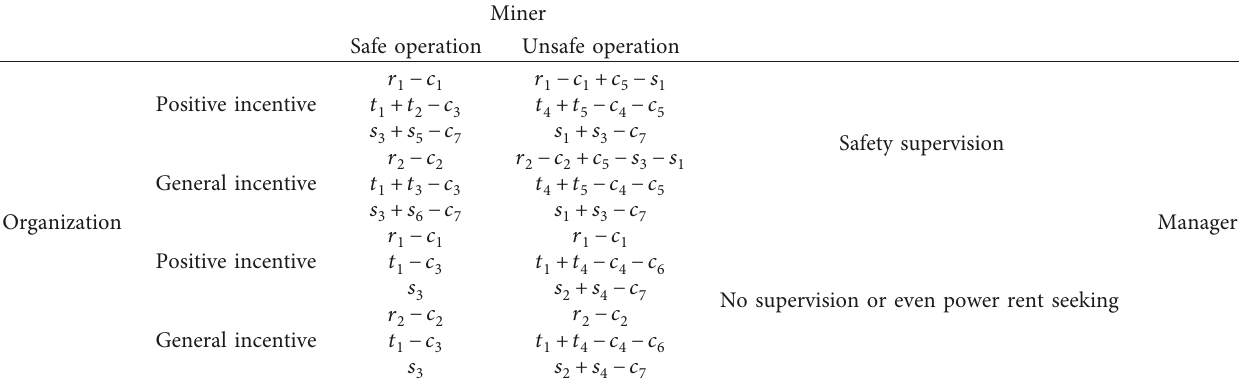
Table 2: Payoff matrix of the three-party